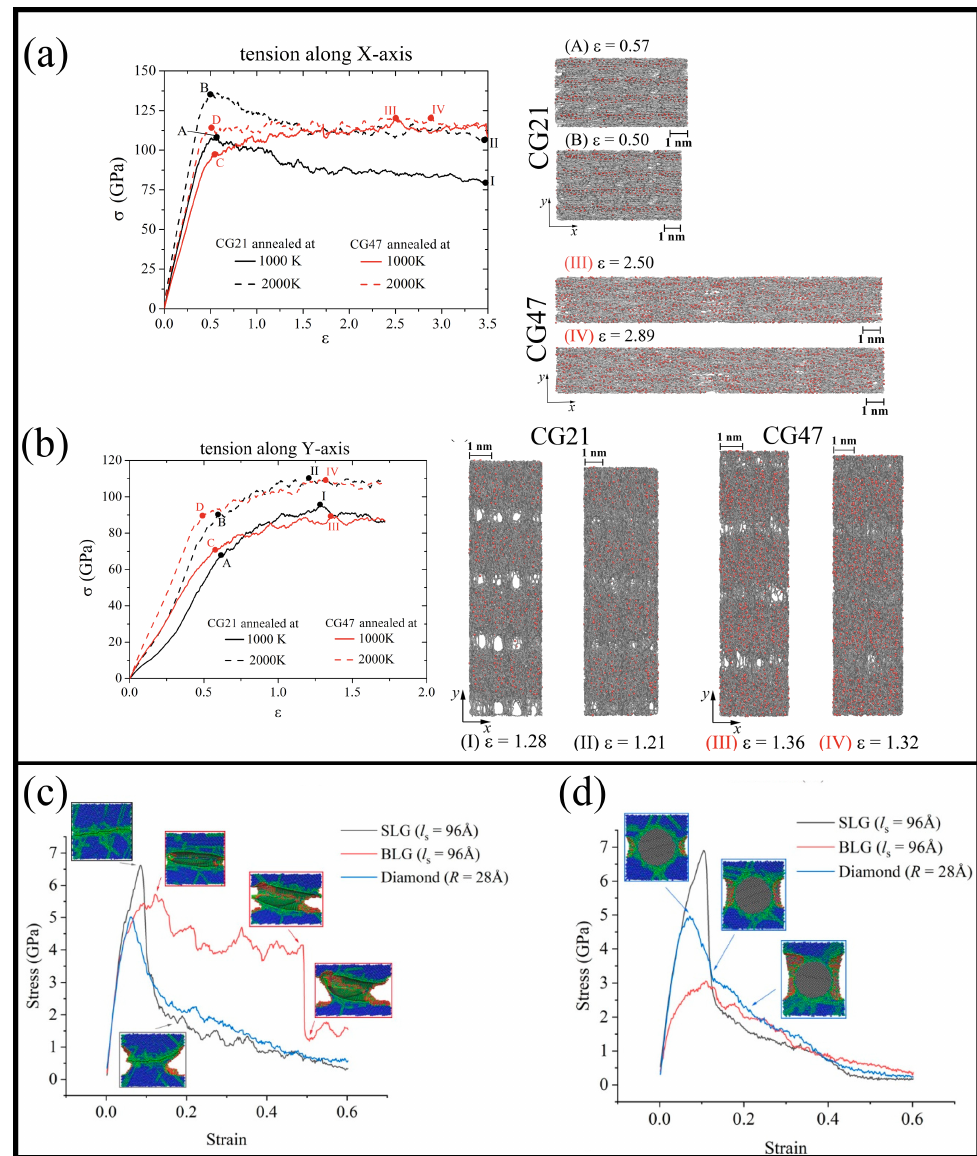
Figure 7. ( a , b ) Stress–strain curves for Ni/graphene composite during uniaxial tension along ( a ) x and ( b ) y with the snapshots of the structure. The composite is crumpled graphene filled with Ni nanoparticles of small (CG21) and average (CG47) size, which was obtained by hydrostatic com- pression followed by annealing at 1000 K or 2000 K. Reprinted with permission from [18]. ( c , d ) The stress–strain curves of sintered Al containing single-layer graphene (SLG), bilayer graphene (BLG), and diamond during tension along ( c ) y direction and ( d ) z direction. Reprinted with permission from